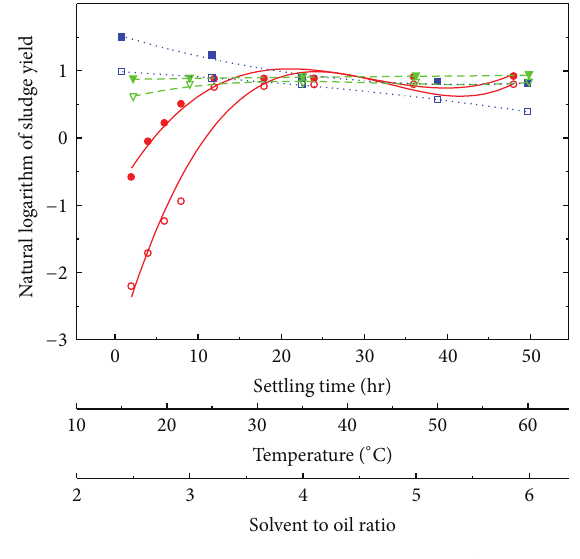
Figure 2: Cubic functional relations between sludge yield and process variables 𝑡 , 𝑇 , and 𝑟 during liquid-liquid